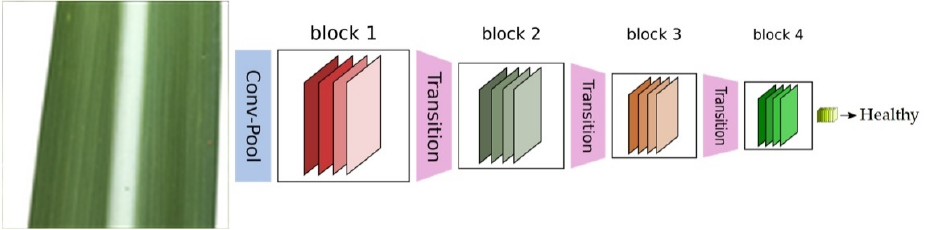
Figure 7. MobilenetV3-large network block structure. Figure 7. DenseNet network block